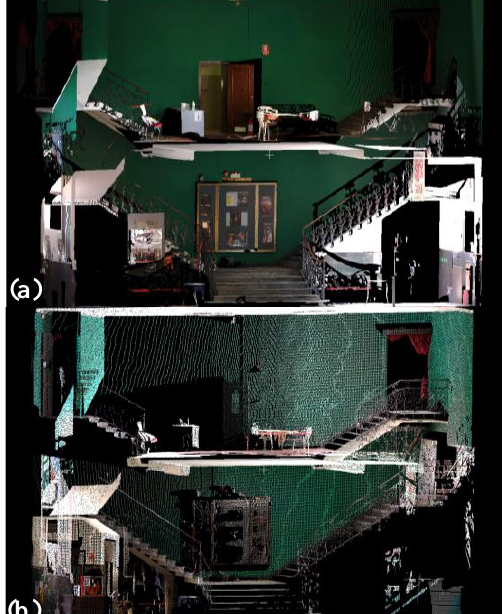
Figure 6. The colour appearance comparison between